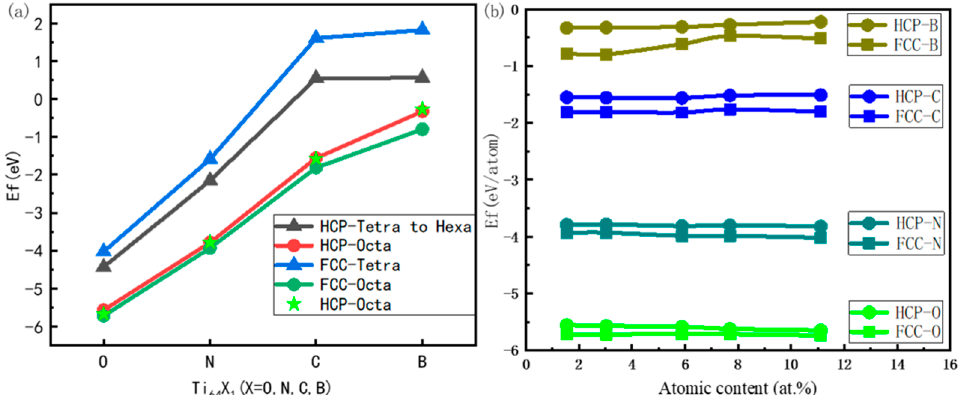
Figure 2. ( a ) The formation energy with different interstitials (data points represented by green stars are from Ref. [35]); ( b ) the relationship between the formation energy of interstitial atoms and the content of interstitial atoms in two structures when interstitial atoms are in octahedral interstitial spaces.